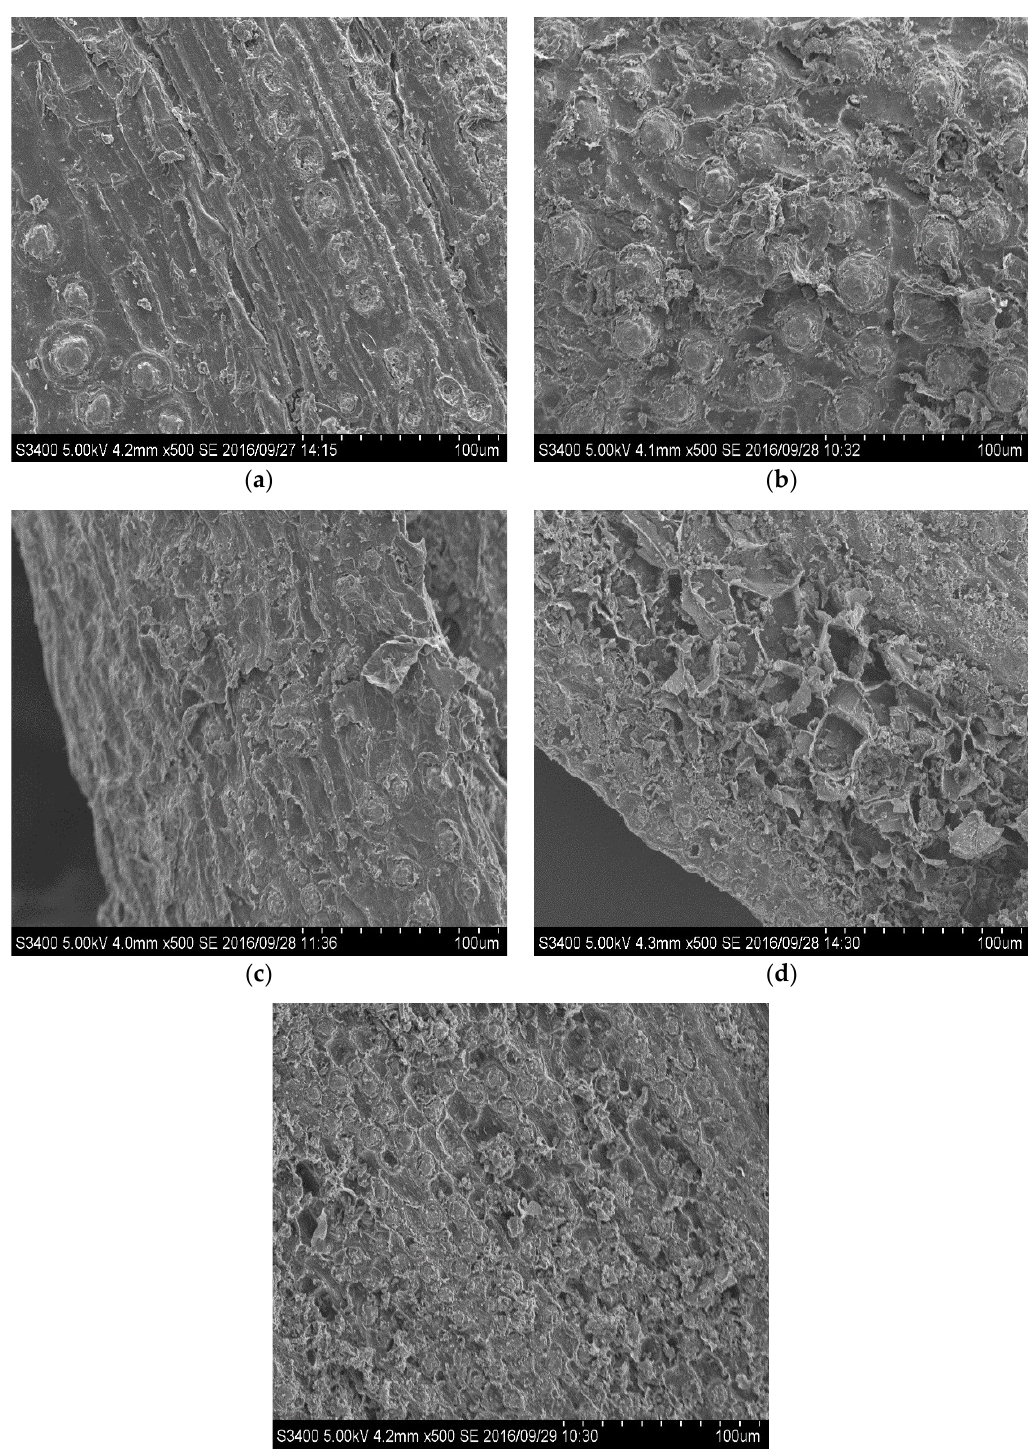
Figure 2. SEM micrographs of ( a ) untreated OPMF ( b ) subcritical H 2 O treatment at 150 °C, 60 min ( c ) subcritical H 2 O-CO 2 treatment at 150 °C, 60 min 5 MPa ( d ) subcritical H 2 O-CO 2 treatment at 170 °C, 40 min, 3 MPa ( e ) subcritical H 2 O-CO 2 treatment at 190 °C, 60 min, 3 MPa obtained with magnification 500×.